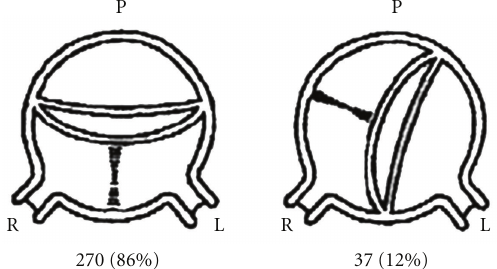
Figure 1: Cusp fusion patterns in BAV disease [4].